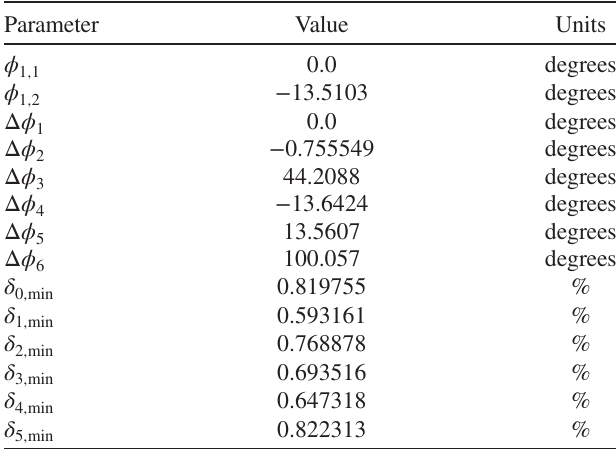
TABLE I. Results of numerical optimization of arc path lengths and initial rf phases that minimize the difference in relative momentum between accelerating and decelerating beams tra- versing the same arcs of a LHeC-like machine. ϕ 1 ; 1 and ϕ 1 ; 2 are